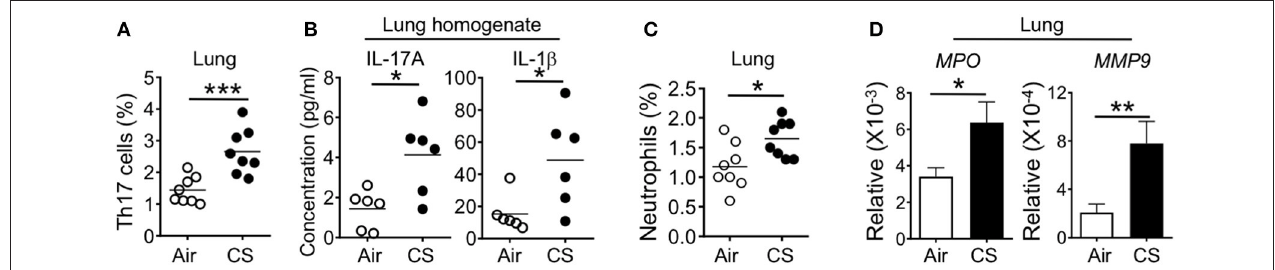
FIGURE 2 | Cigarette smoke induces lung Th17 cell and neutrophil responses. Mice were exposed to air or CS for 2 months. (A) Percentages of ROR γ t + cells among lung CD3 + TCR β + CD4 + T cells. (B) Cytokines in lung homogenates as determined by Luminex assay. (C) Frequencies of neutrophils (CD11b + Ly6G + cells) in the lung of mice exposed to air or CS for 2 months. (D) Lung mRNA expression of neutrophil response genes as determined by qRT-PCR. Data is representative of two independent experiments with 6–8 animals per group (mean ± SEM). Student’s t -test (A,C,D) or Mann-Whitney test (B) was used to determine significance. * P ≤ 0.05; ** P < 0.01; *** P <